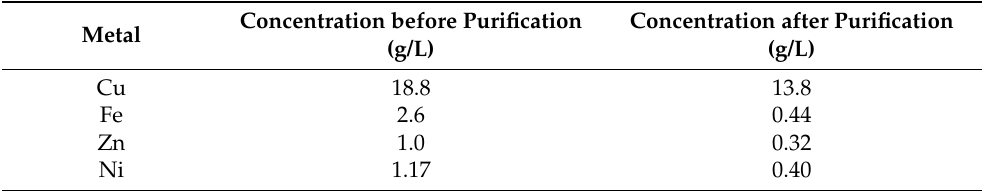
Table 4. Analysis of the pregnant solution before and after purification at pH 3.0.